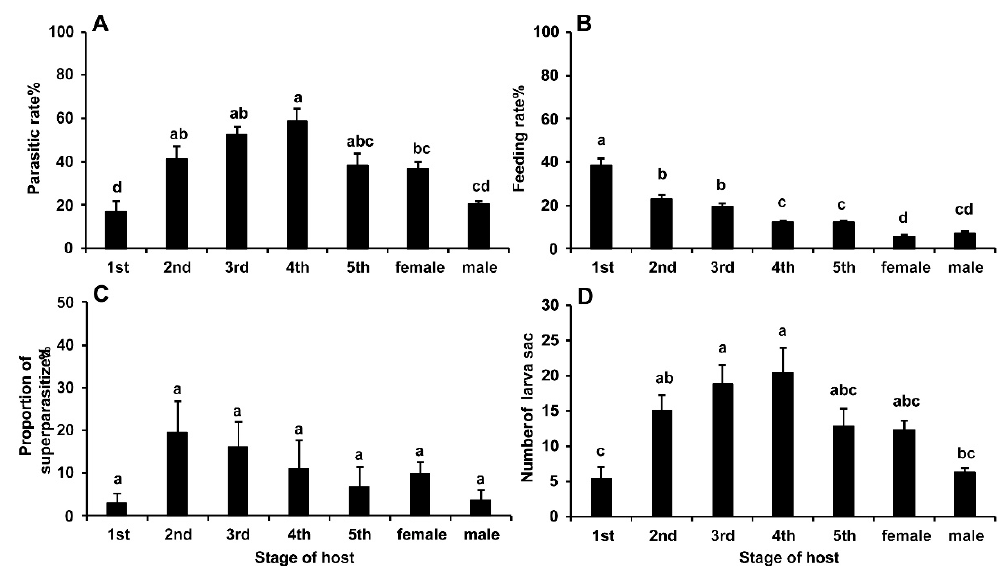
Figure 2. Effects of BPH life stage on parasitism and host-feeding rates in Gonatopus flavifemur . ( A ) parasitism rate; ( B ) feeding rate; ( C ) percentage of superparasitized individuals; ( D ) number of larval sacs. Note: bars within each panel with the same letter above show no significant difference at the 0.05 level according to Tukey’s multiple comparison tests. The same in the following figures.